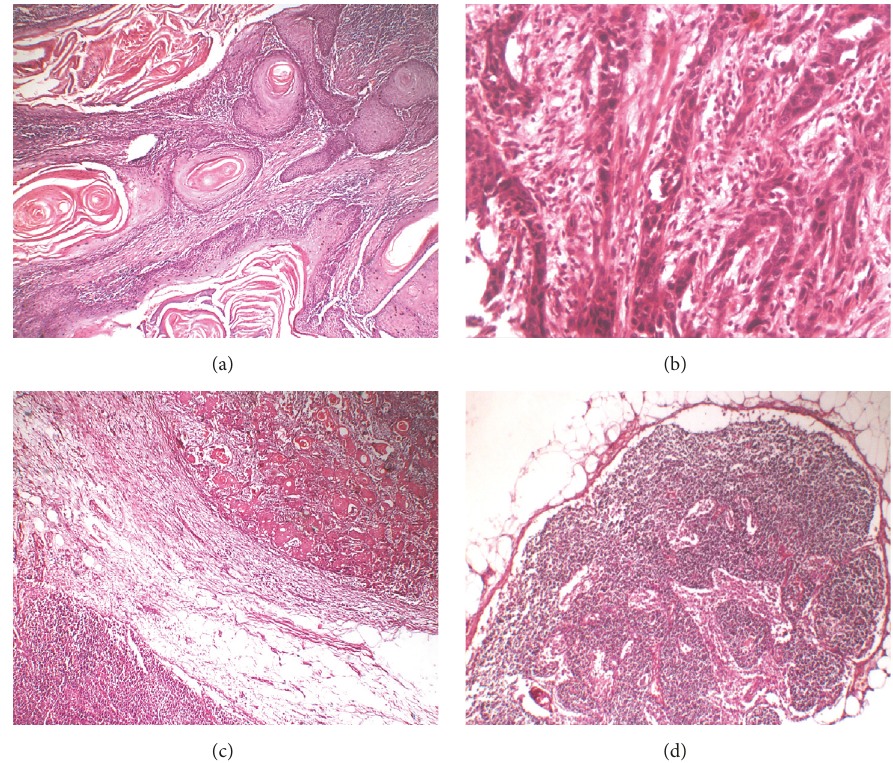
Figure 1: Photomicrographs of H&E stained sections showing different grades of OSCC ((a) × 40), ((b) × 100) and OSCC associated positive ((c) × 40) and negative ((d) × 40) lymph